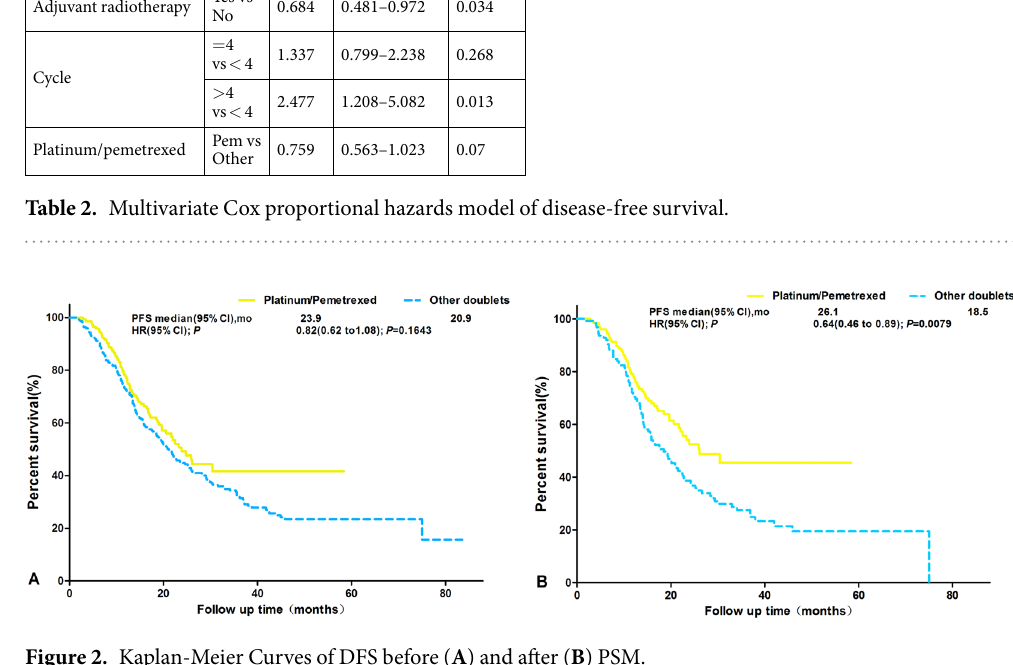
Figure 2. Kaplan-Meier Curves of DFS before ( A ) and after ( B )